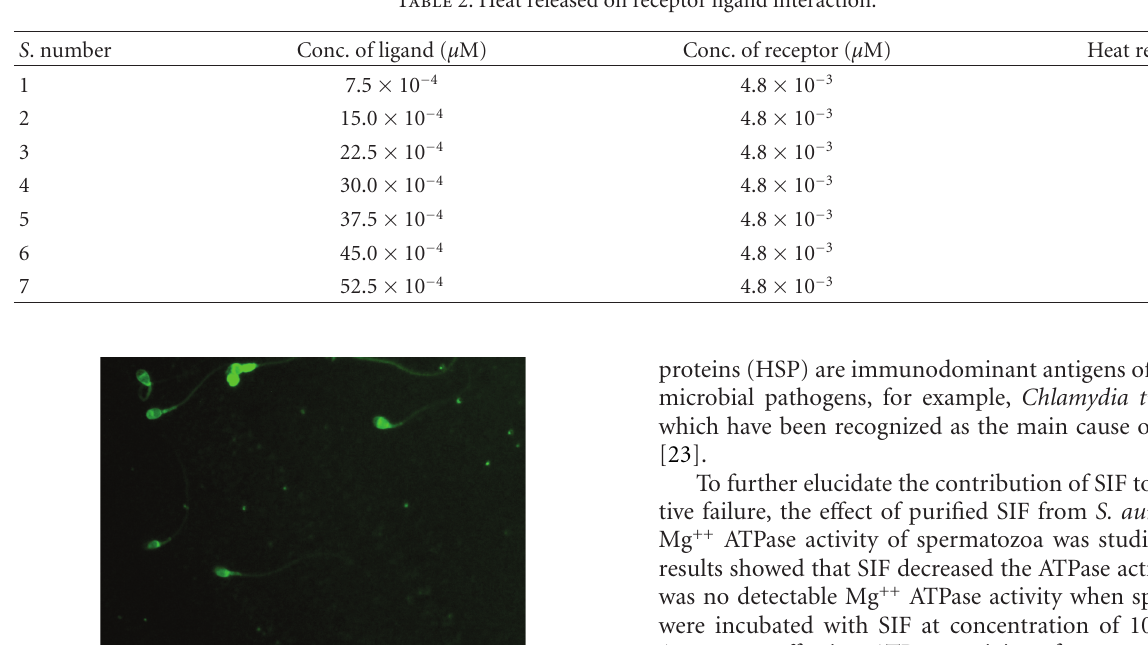
Table 2: Heat released on receptor ligand interaction.